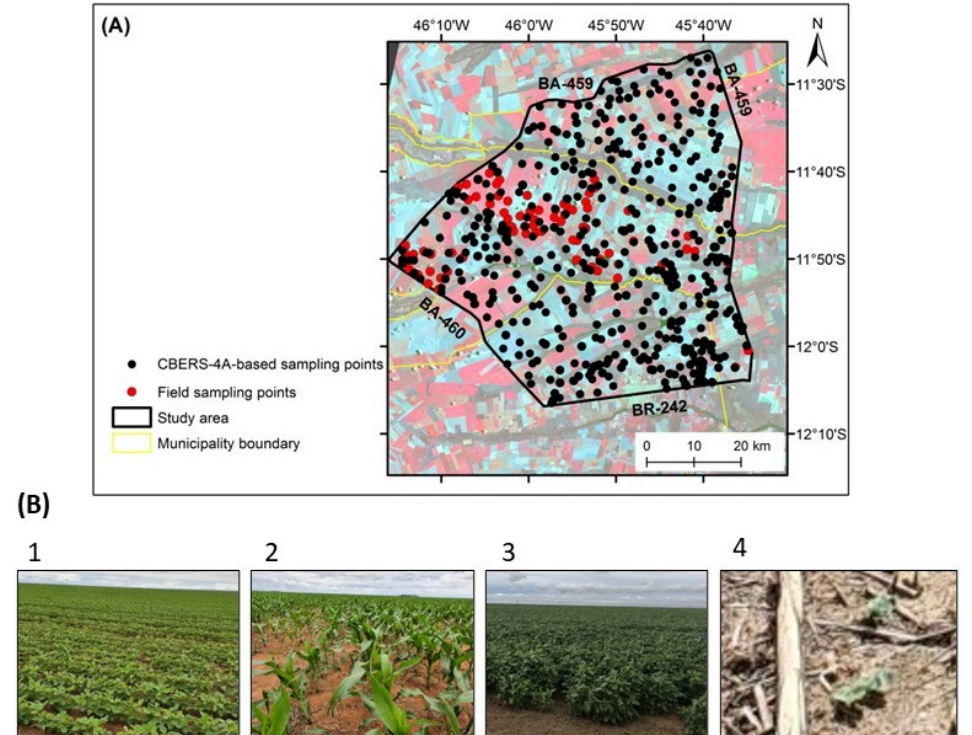
Figure 4. ( A ) Location of the field sampling points and remote sensing-based reference points. The field campaign was conducted on 29 − 30 November 2021. The image used for remote sensing-based points was obtained by the CBERS-4A satellite with the overpass on 27 October 2021. ( B ) Field photos of agricultural fields illustrating the studied crops: (1) soybean; (2) maize; (3) bean; and (4) recently planted cotton (presence of maize straw).